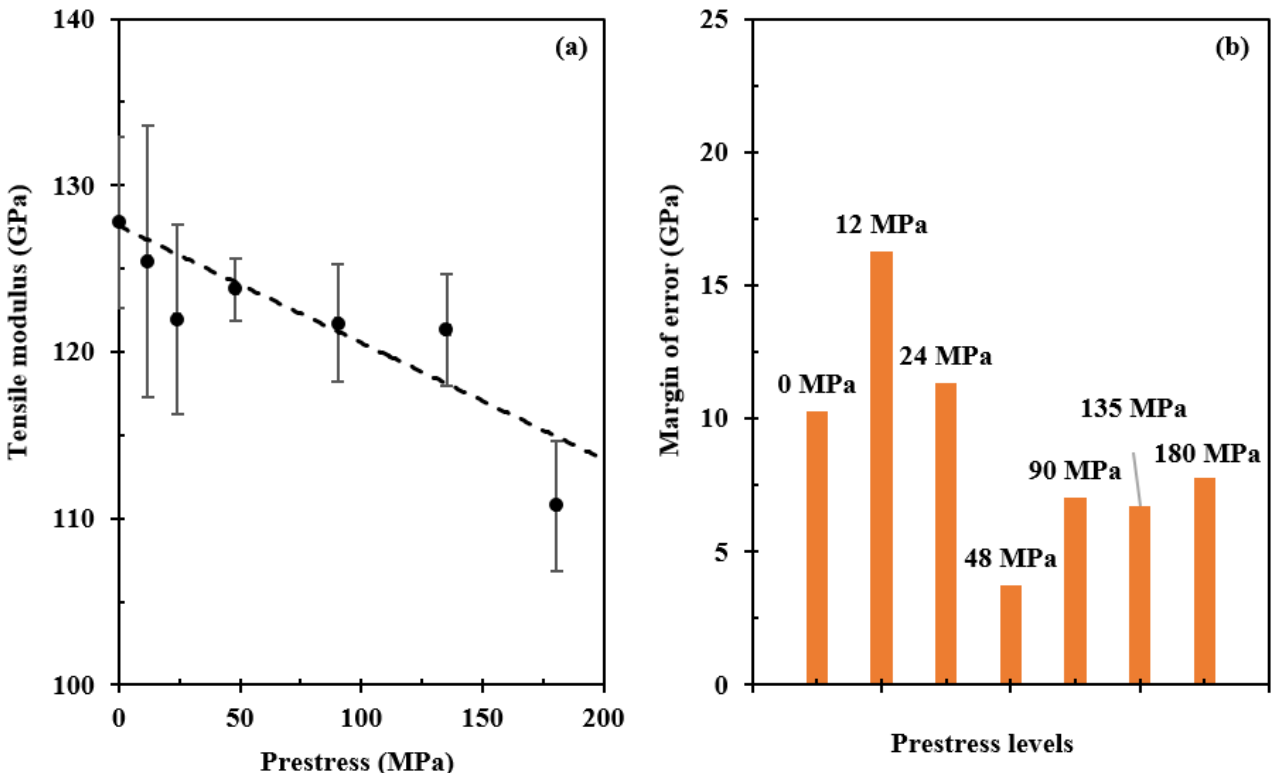
Figure 6. Effects of fibre prestressing level on tensile modulus of the composite. Each case was tested three times, and standard errors are presented by error bars in ( a ), and ( b ) shows the margins of error at different prestress levels marked by the data labels.